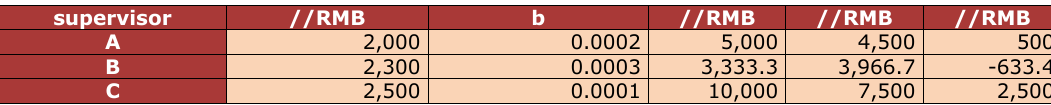
Table 1. The calculated results of game analysis between the owner and the